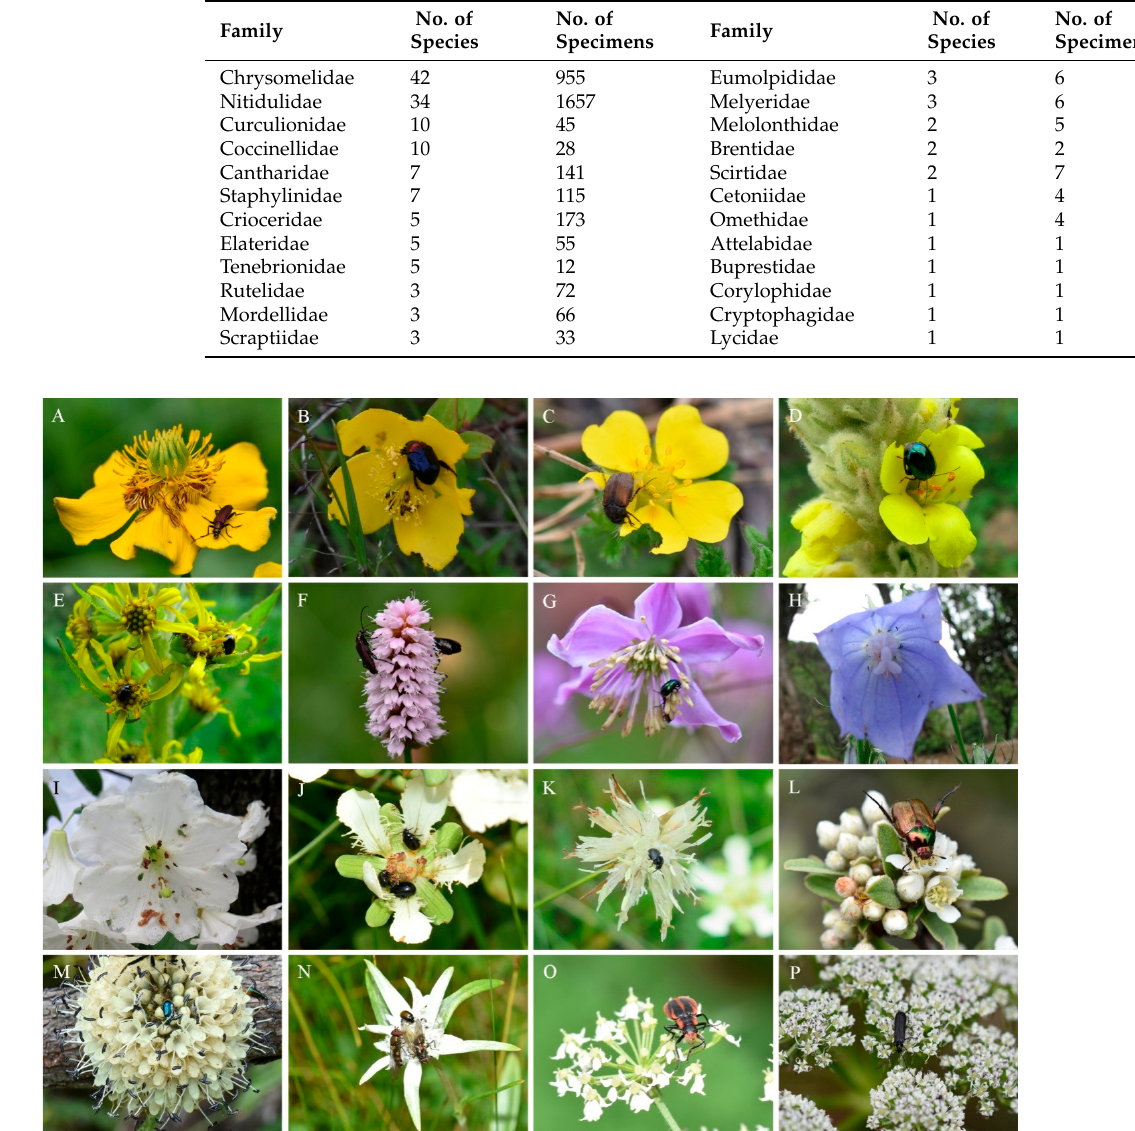
Figure 1. Flowers and their beetles on Yulong. Living, uncollected insects were not easy to identify to species and most here are identified to family and/or genus. ( A ): Trollius yunnanensis (Franch.) Ulbr. (Ranunculaceae) and a species in